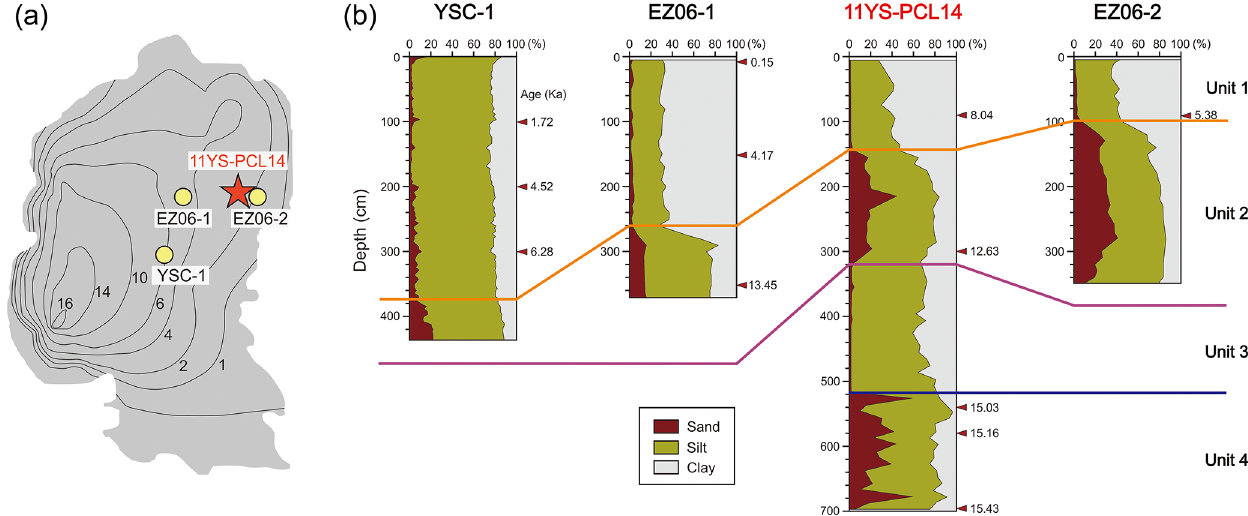
Figure 2. (a) Isolines in thickness (m) of mud deposit CYSM (after Wang et al., 2014). (b) Vertical lithology profile of core 11YS-PCL14 and other reference cores (YSC-1, Li et al., 2014a; EZ06-1 and EZ06-2, Lim et al., 2015).